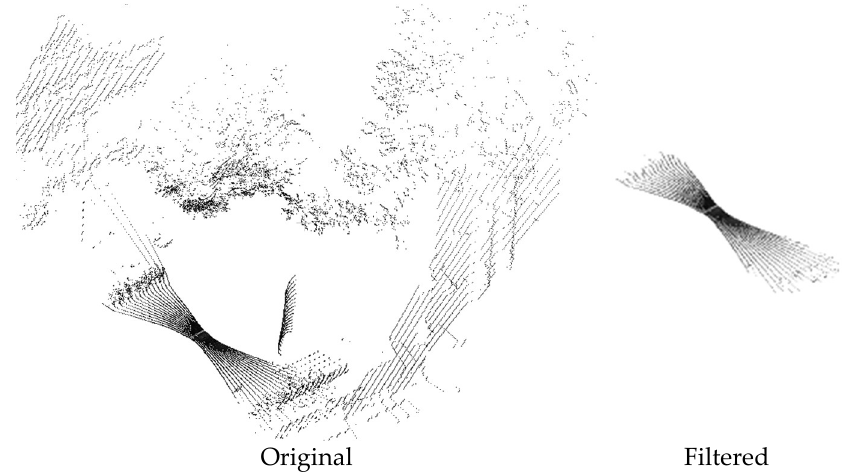
Figure 4. Sample sparse point cloud before ( left ) and after ( right ) filtering.